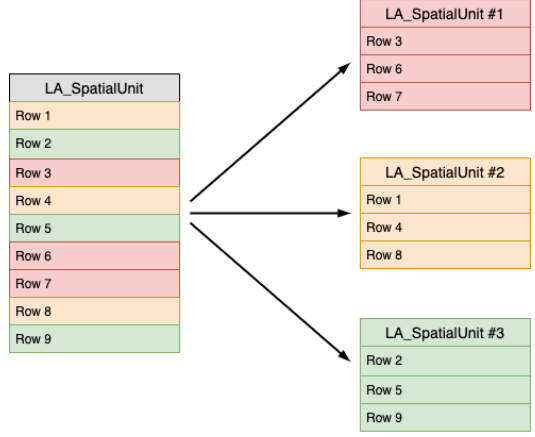
Figure 4. An example of horizontal partitioning.